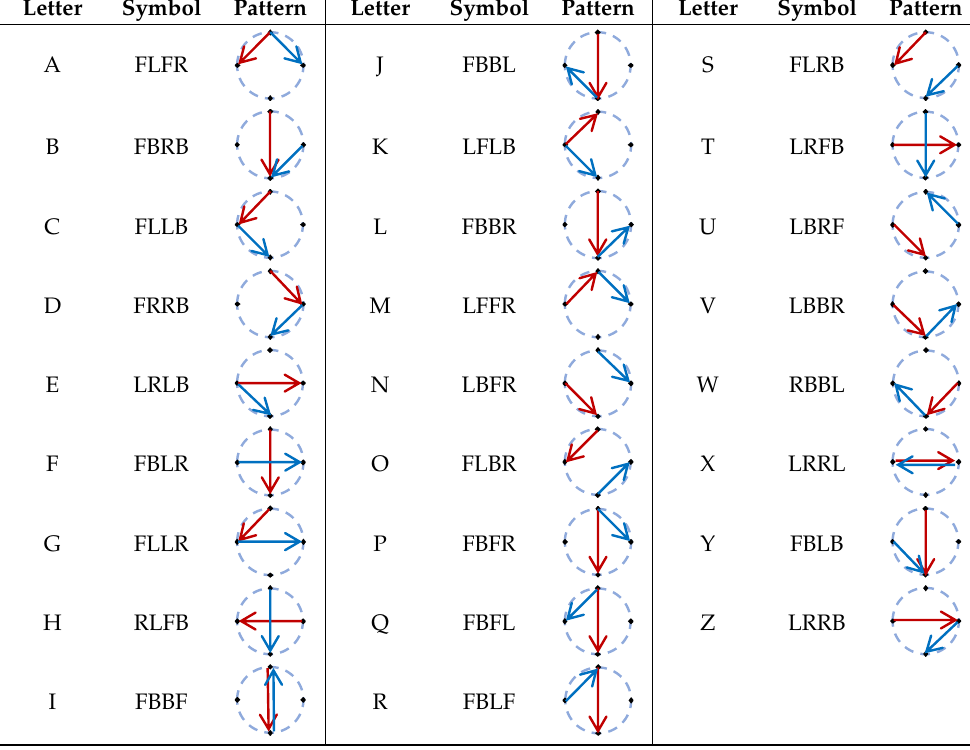
Table 2. The vibrotactile alphabet for the choker. In the columns of symbols, abbreviations of two strokes are given (see Figure 3). Red arrows in the pattern columns indicate the first stroke, while blue arrows indicate the